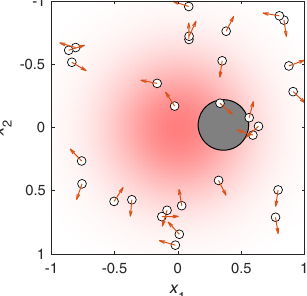
FIG. 7. Setup for our numerical case study. A passive particle (gray) trapped in a harmonic potential (indicated in red) interacts with many active Brownian particles (white) that are self- propelled in randomly varying directions (orange